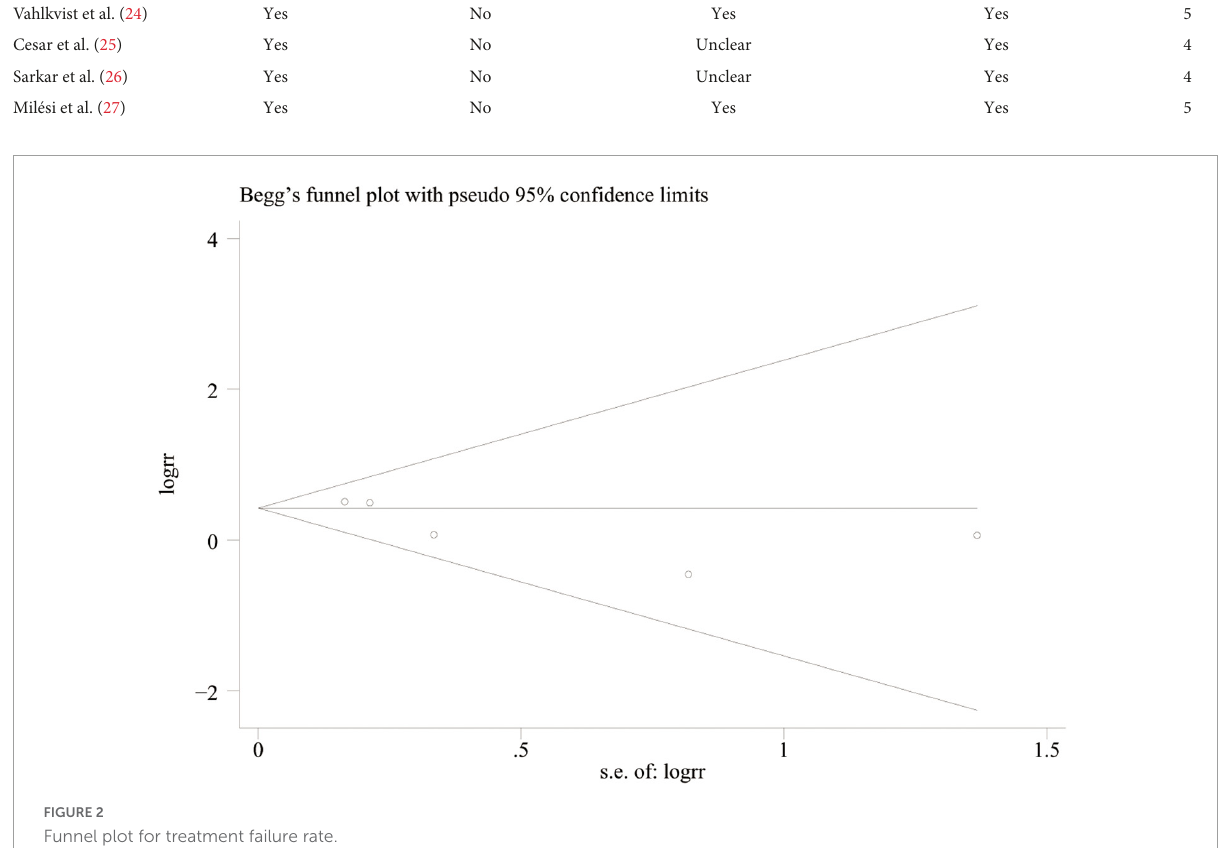
FIGURE2 Funnel plot for treatment failure